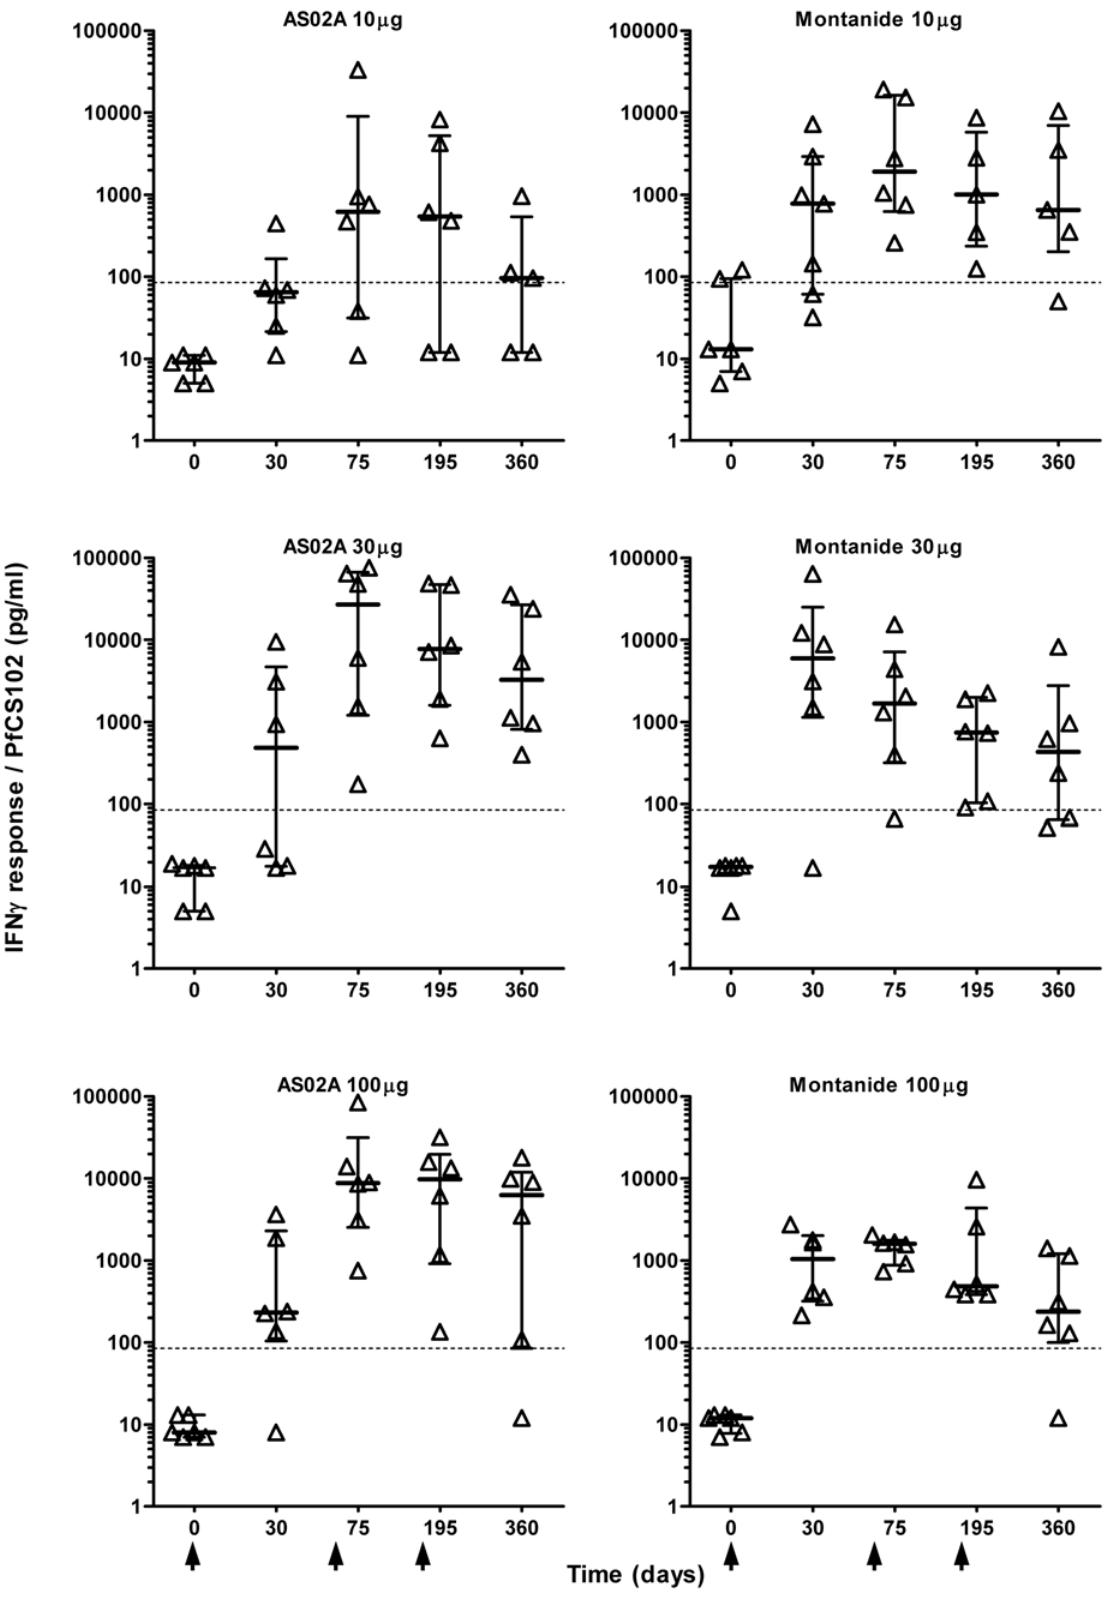
Figure 5. Time-course of the IFN- c production by PBMC in response to PfCS102. IFN- c was evaluated in the supernatant of stimulated peripheral blood mononuclear cells (PBMC). Results are expressed as individual IFN- c secretion, expressed in pg/ml for each immunization group, with quartiles. Arrows indicate the times of vaccination.